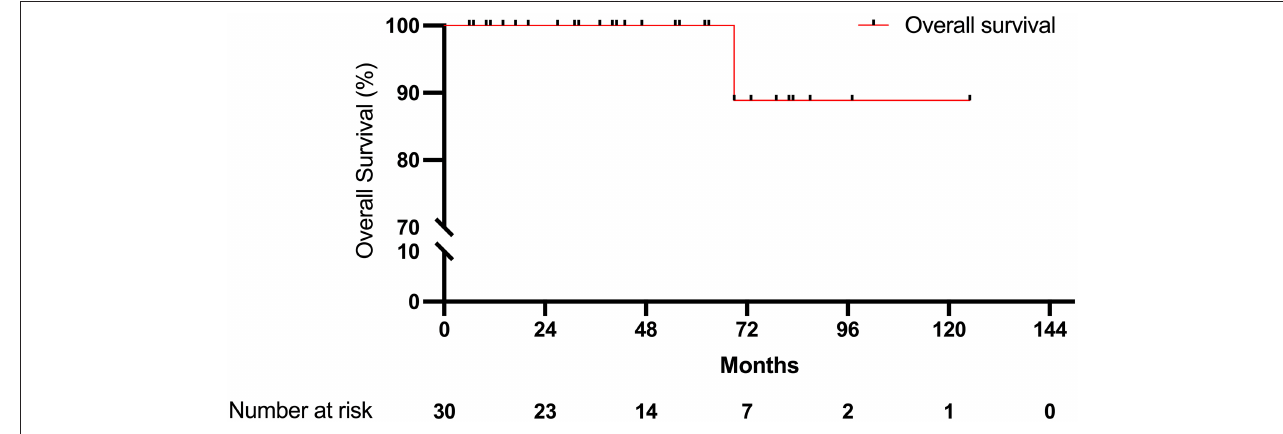
FIGURE 3 | Overall survival.